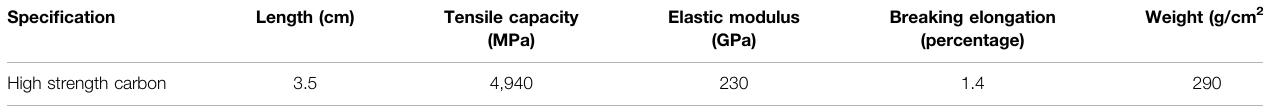
TABLE 3 | Characteristics of Discarded carbon fi bers (CFs).